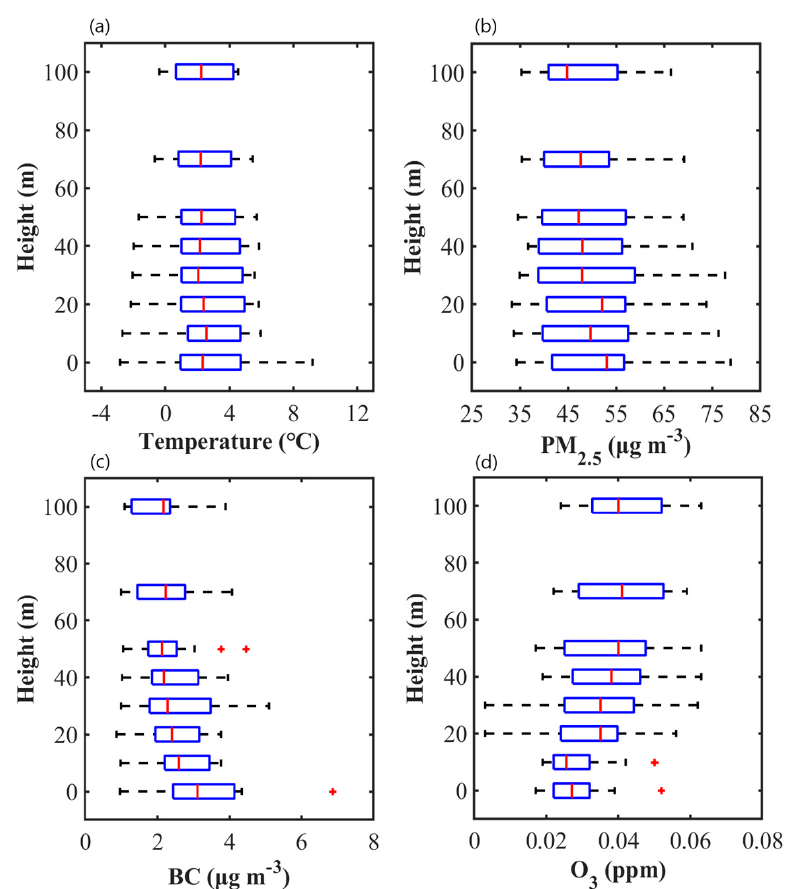
Figure 7. Vertical profiles of ( a ) air temperature, ( b ) PM 2.5 , ( c ) BC, and ( d ) O 3 concentration boxplots for six days of P1D and P2D periods. A number of measurement data is 18 per each altitude. BC and NO x are commonly emitted from vehicles and have a strong correlation (R 2 ≥ 0.78) in the